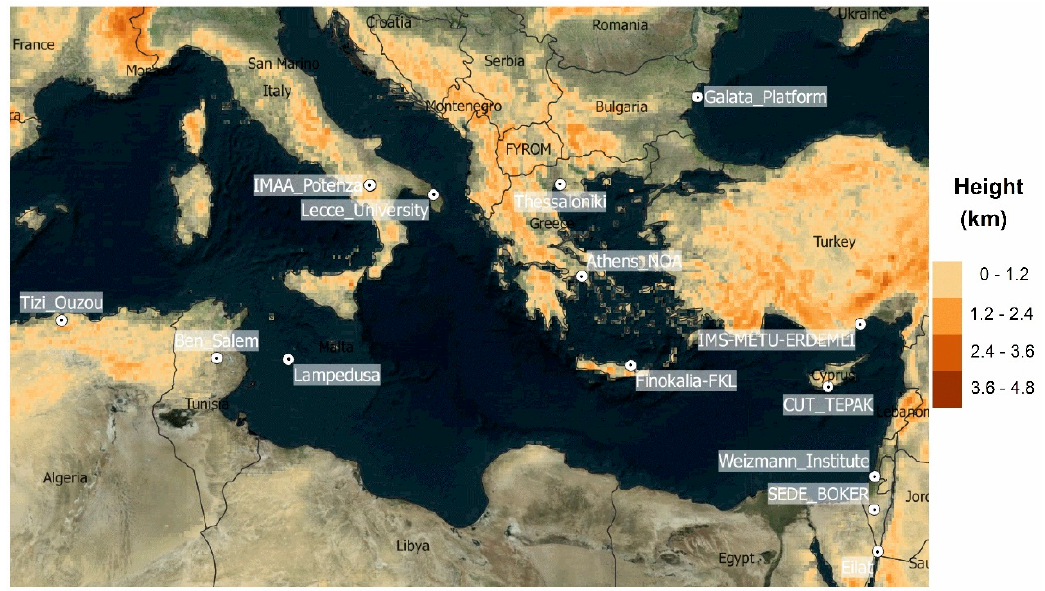
Figure 1. The domain of the study. The 14 Aerosol Robotic NETwork (AERONET) stations (white circles) used in the study are indicated. The brownish colored areas highlight mountainous areas with an altitude greater than 800 m.